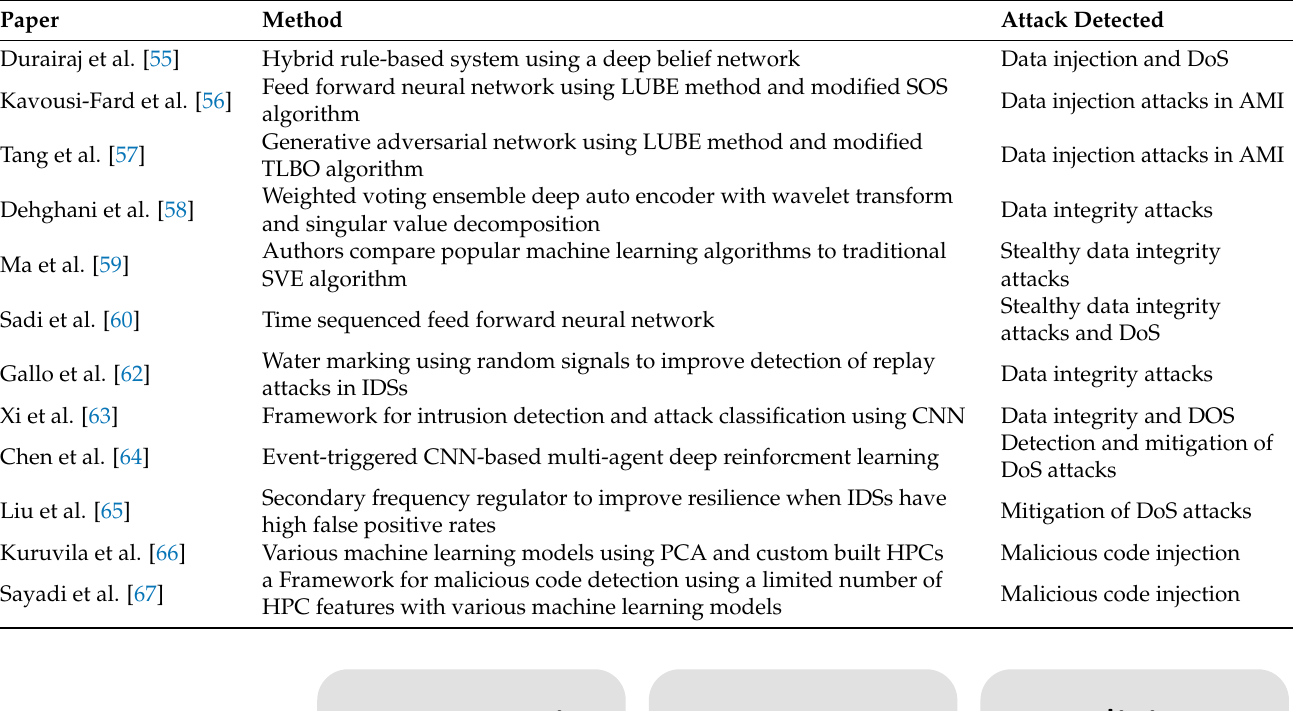
Table 4. Microgrid IDPS.